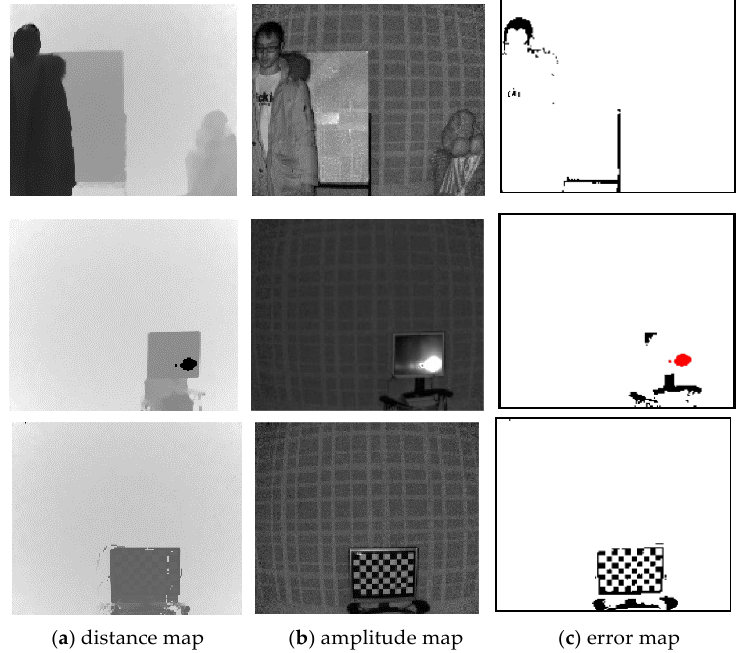
Figure 12. Results of error detection.